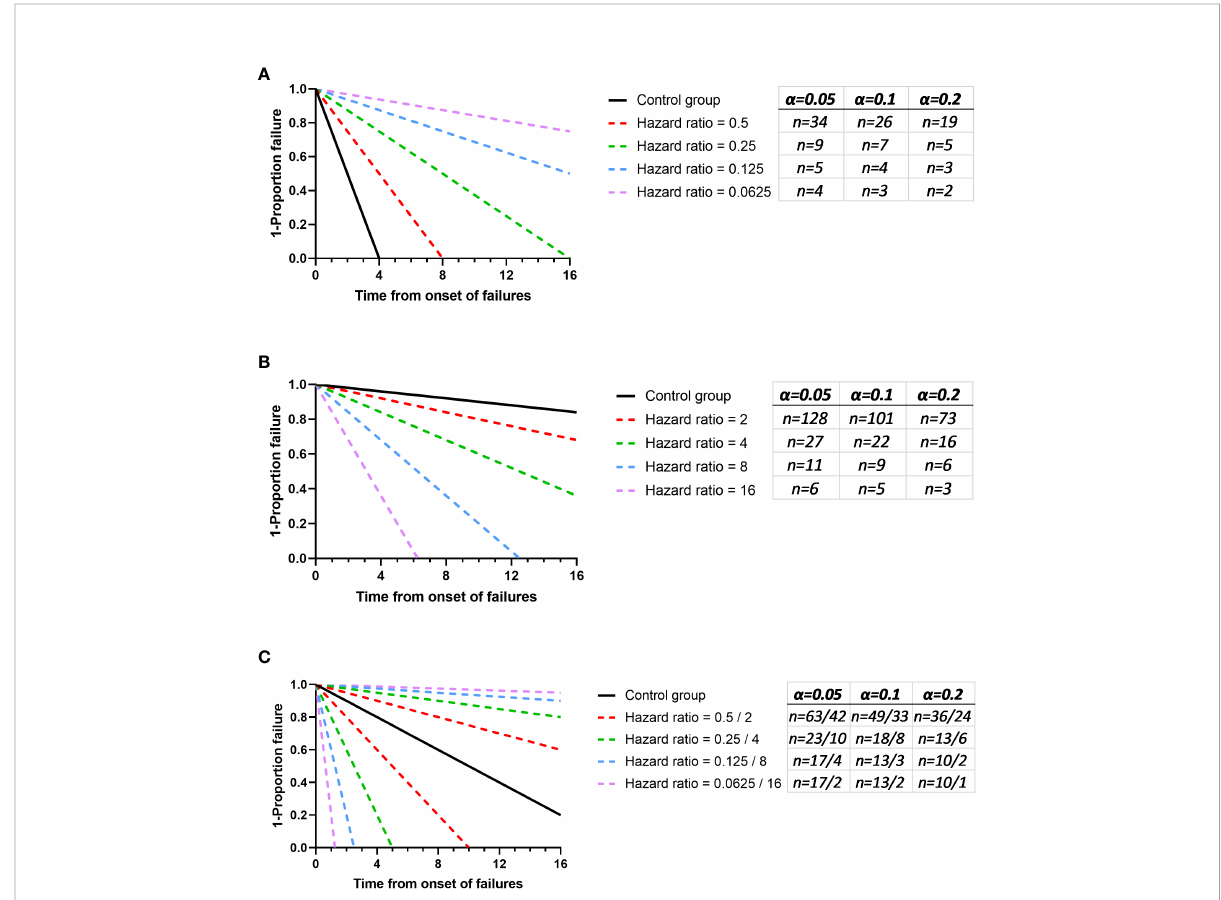
FIGURE 1 The expected values for n to visualise a signi fi cant difference with 80% power and 5%, 10% and 20% alpha. Fixed control groups have been used in each panel and comparator groups with varying effect sizes were used. The sample size calculated for each comparison are added in red. (A) shows an experiment where the test group is expected to improve outcome and here the control is considered to have a median survival of 2 time units post onset of failures. (B) shows an experiment where the experimental group is likely to increase the failure rate and here the control is considered to have a median survival of 50 time units post onset of failures. (C) shows an experiment with no bias in aspiration outcome and here the control is considered to have a median survival of 10 time units post onset of failures. Graphs were generated using Graphpad PRISM V8.0 (San Diego), using the ‘ plot line ’ function, where the plots of y = a+bx were used and the power analysis was performed using PS: Power and Sample Size Calculation V3.0 (https://biostat.app.vumc.org/wiki/Main/PowerSampleSize). The software uses the method described by Schoenfeld et al. (Schoenfeld and Richter,